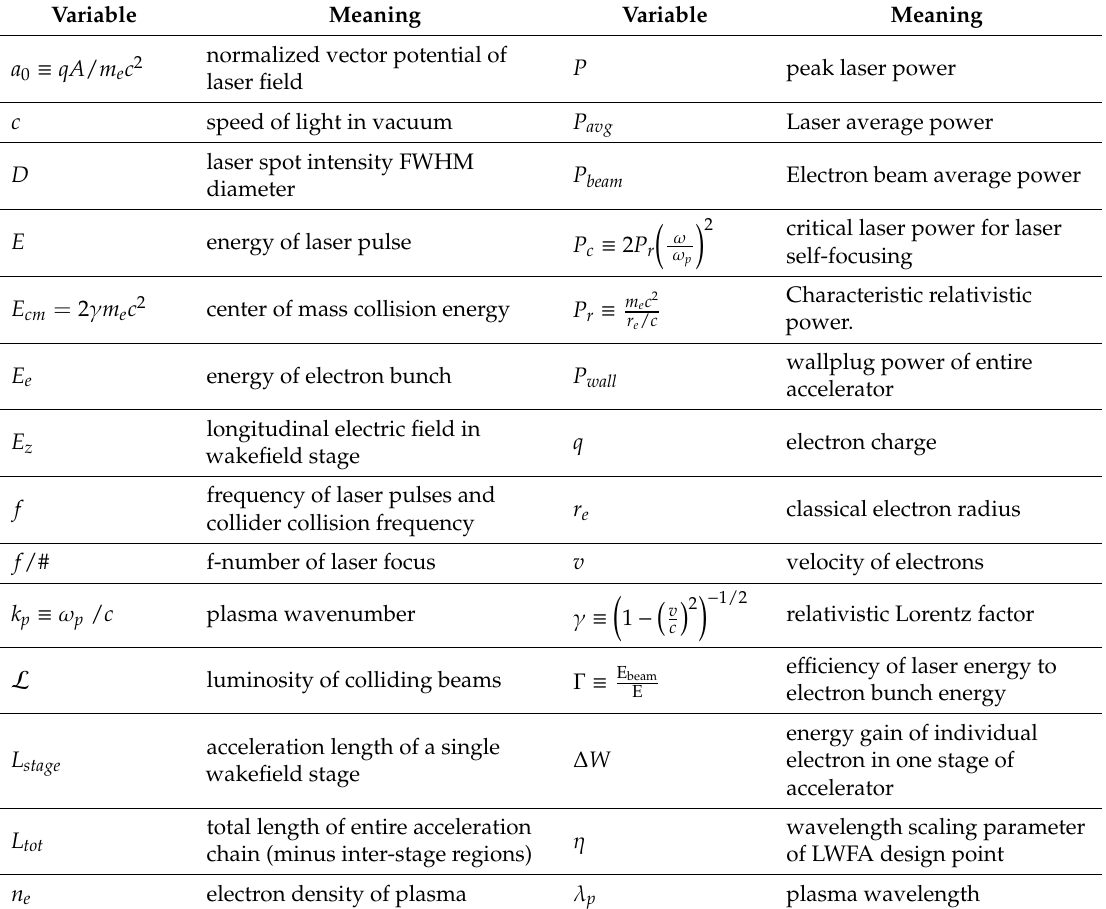
Table A1. Summary of